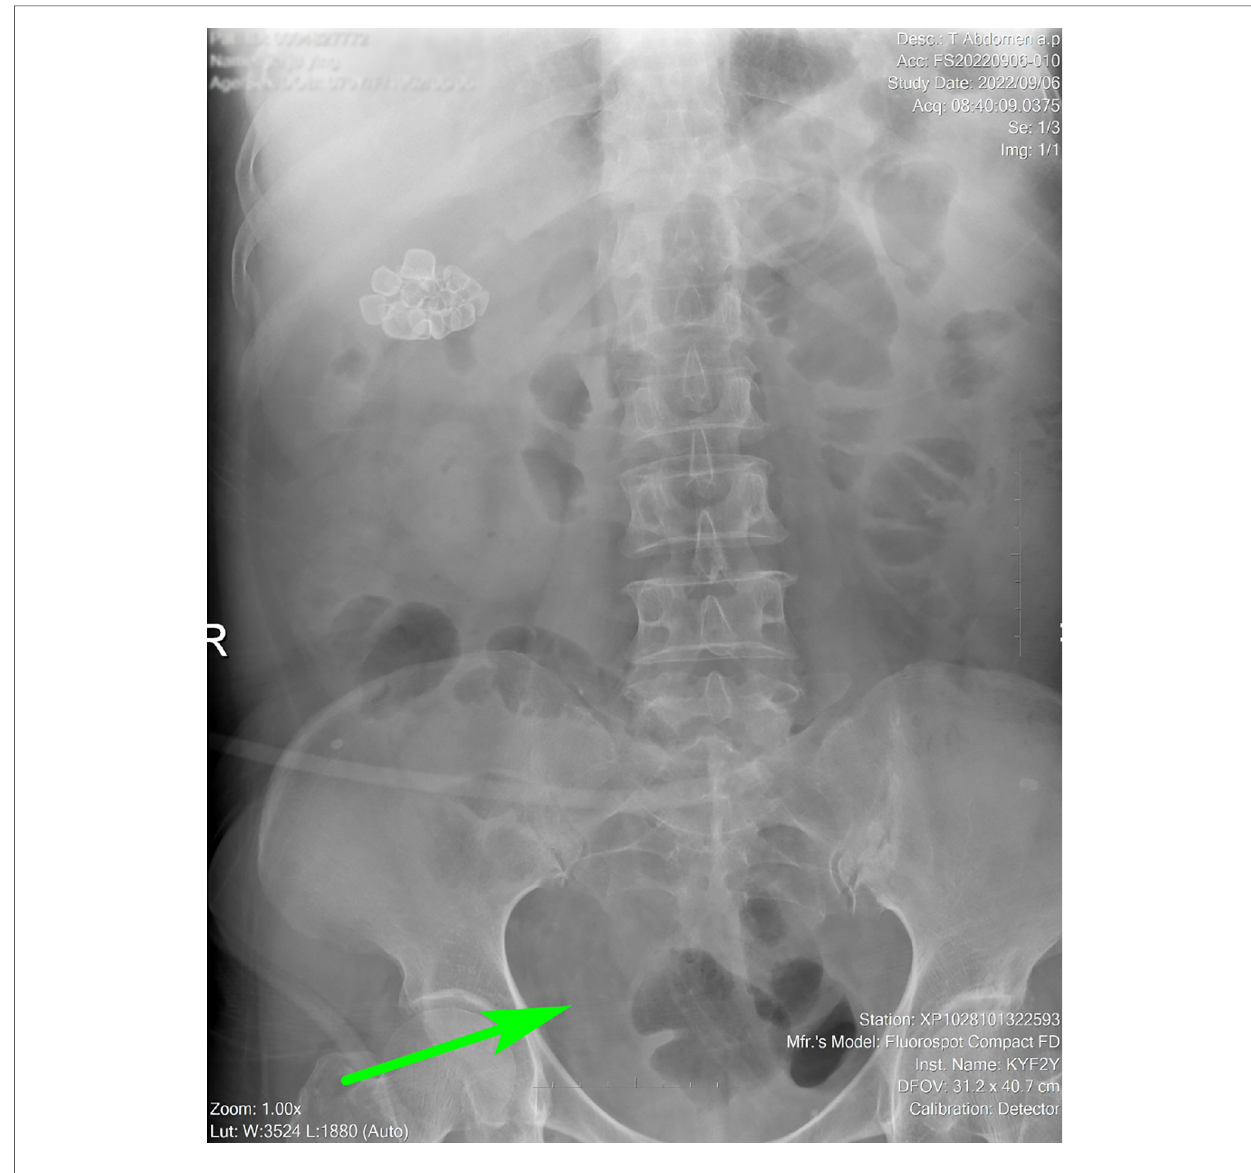
FIGURE 3 Postoperative abdominal x-ray showing no stones (green